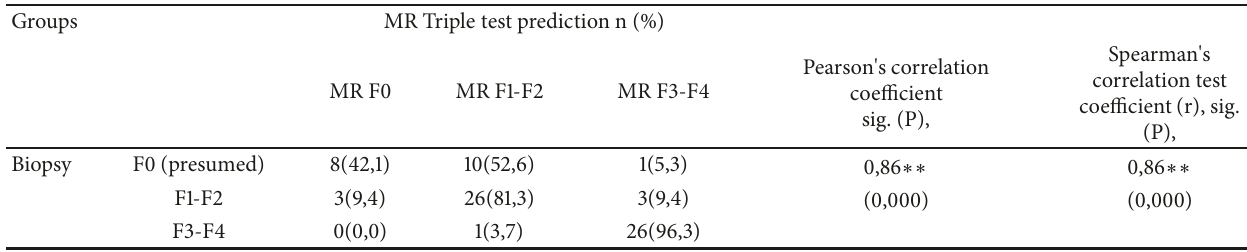
Table 6: The correlation between biopsy and Triple test.